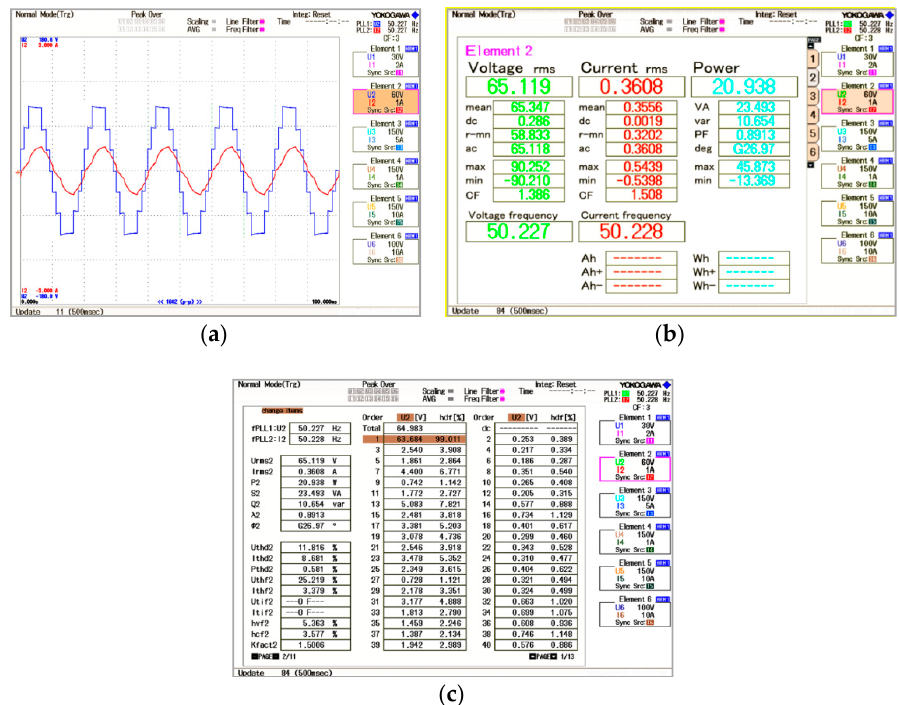
Figure 11. Experimental results for 7-level inverter ( a ) output voltage and current waveform ( b ) output from power quality analyzer and ( c ) voltage harmonics.